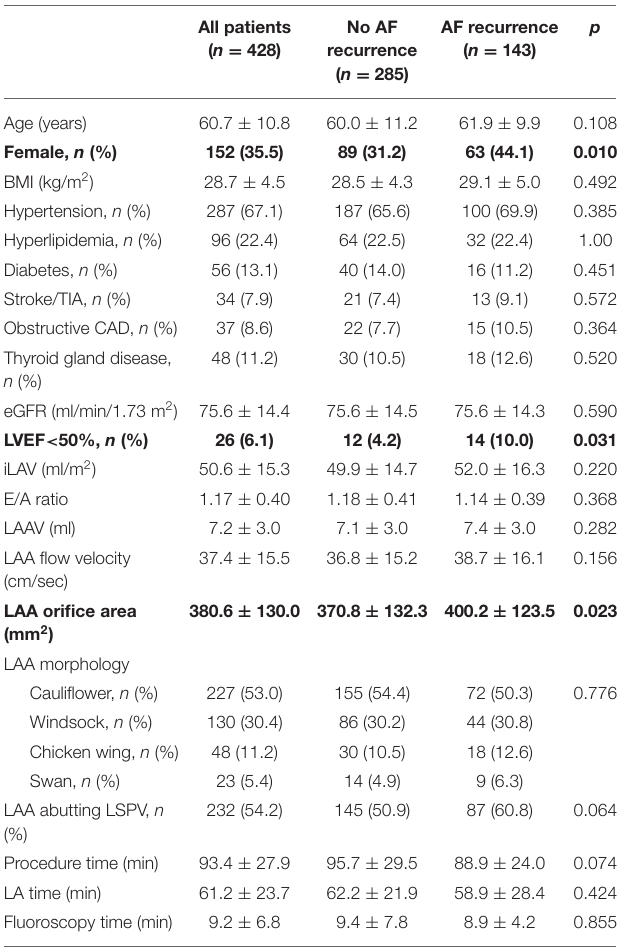
TABLE 1 | Patient